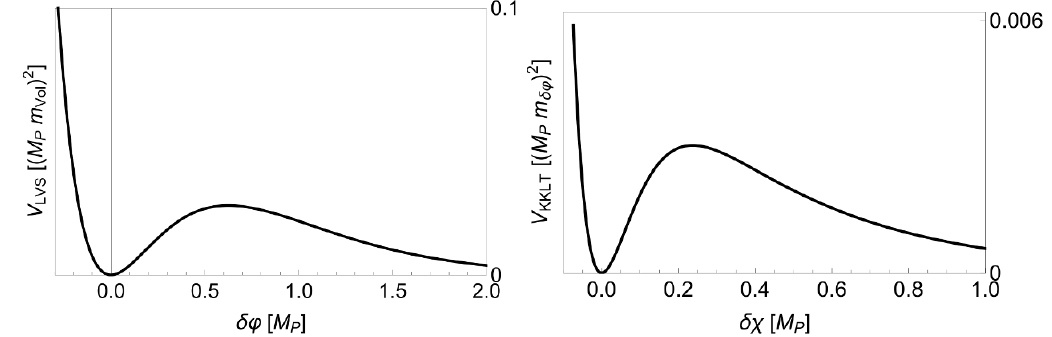
Figure 1 . Left panel : LVS potential in terms of the canonically normalized (cid:12)eld (cid:14) ~ ’ in Planck units. Right panel : KKLT potential in terms of the canonically normalized (cid:12)eld (cid:14) ~ (cid:31) in Planck units. 2 where the normalization is V = 3 P j W 0 j 0